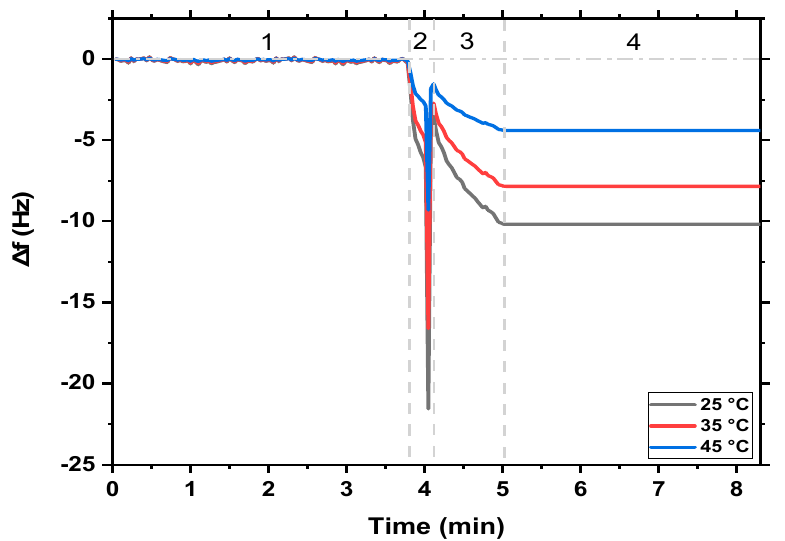
Figure 4. The real-time detection of MB dye (400 mg/L) by MgFe 2 O 4 NPs nanosensor at different temperatures (25 °C, 35 °C, and 45 °C); zone (1) shows the QCM monitoring of MgFe 2 O 4 NPs nanosensor, (2) indicates the first injection of MB, (3) represents the adsorption of MB on the nanosensor surface, and (4) adsorption equilibrium of MB.